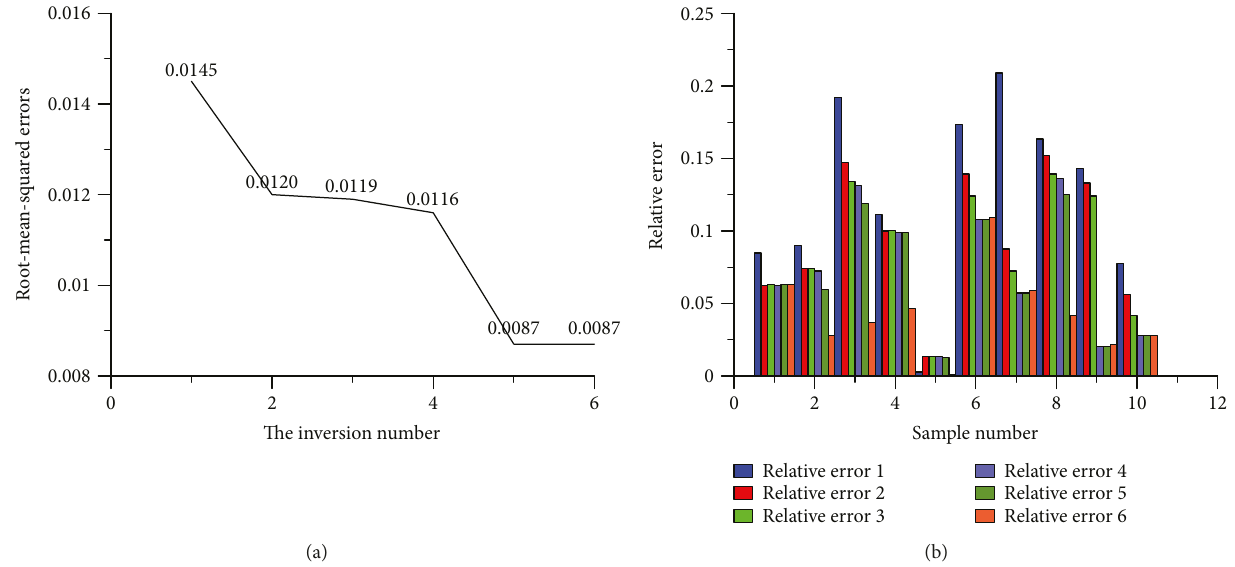
Figure 12: Error variation of the inversion values as inversion iteration number increases. (a) The root-mean-squared error of copper ion content. (b) The relative error variation of water